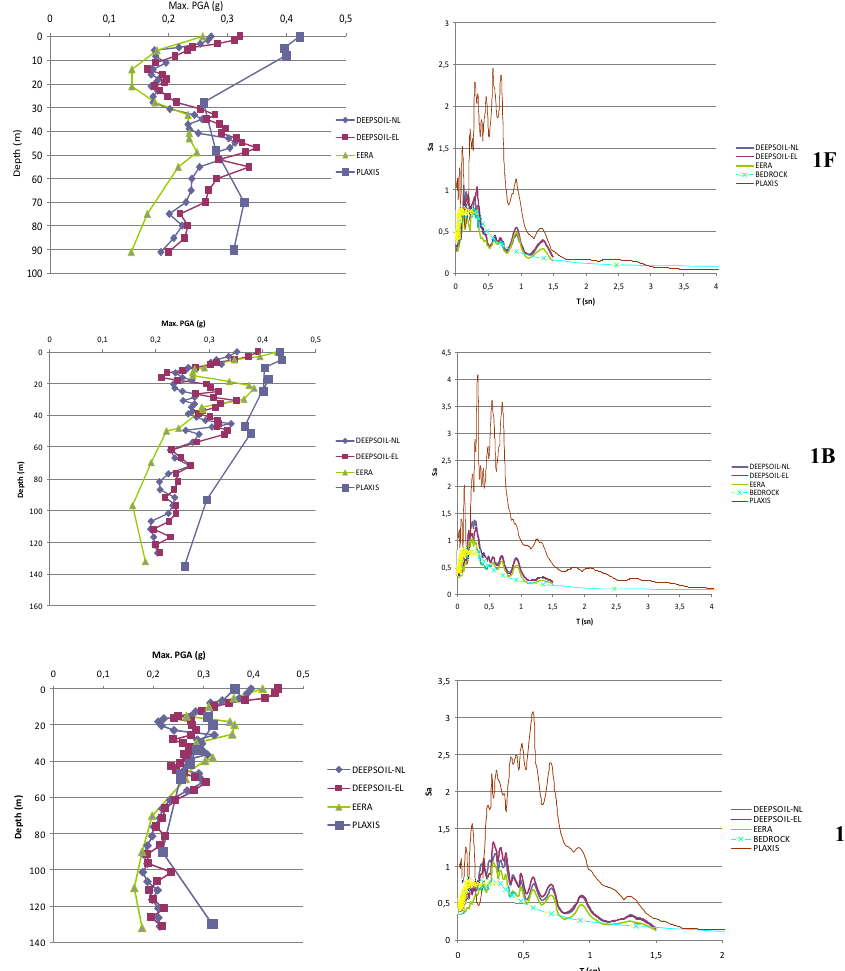
Figure 15. 1-1 0 section; maximum acceleration depth and spectral acceleration period graph for the selected